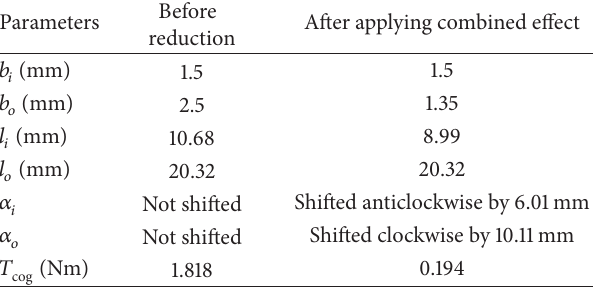
is 1.5 mm and the slot opening width of outer slots ( 𝑏 𝑜 ) is 1.35